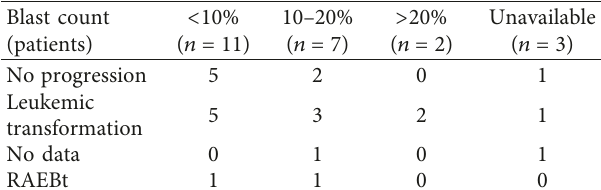
Table 1: Patient characteristics, cytogenetics, time to progression, treatment outcomes, and bone marrow blast